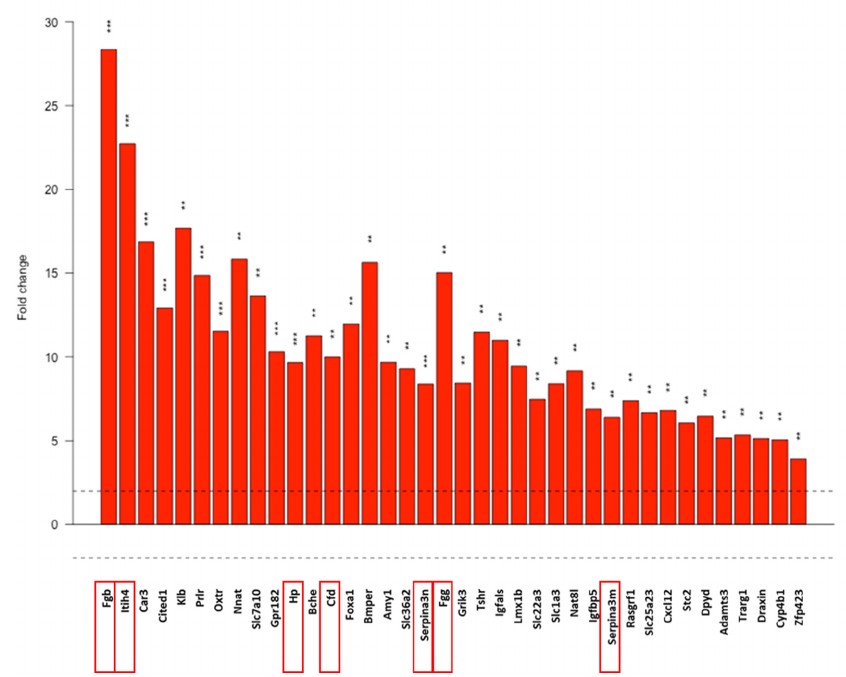
Figure 6. Response to stimulus pathway based on the gene-ontology (GO) analysis of the NGS data. Dotted line: FC = 2. Red frames: further analyed genes. Gene names, p values and further pathways containing stress-related genes analyzed with the DEListEnrichment_upR module are presented in Table S2. **: p < 0.01, ***: p < 0.001. Cell line: 4T1, 3× treated. Table 2. Cellular stress response upregulated by mEHT treatment. Genes (official name abbreviations as used in all multiplex platforms and descriptions of the coded proteins) detected as upregulated with all three multiplex methods (NGS RNA Seq, Nanostring, MS) are designated with bold letters. Nanostring validated all NGS hits with a similar FC value. Hspa1a and Hspa1b are the most common isoforms of Hsp70. Cell line: 4T1, 3 × treated.